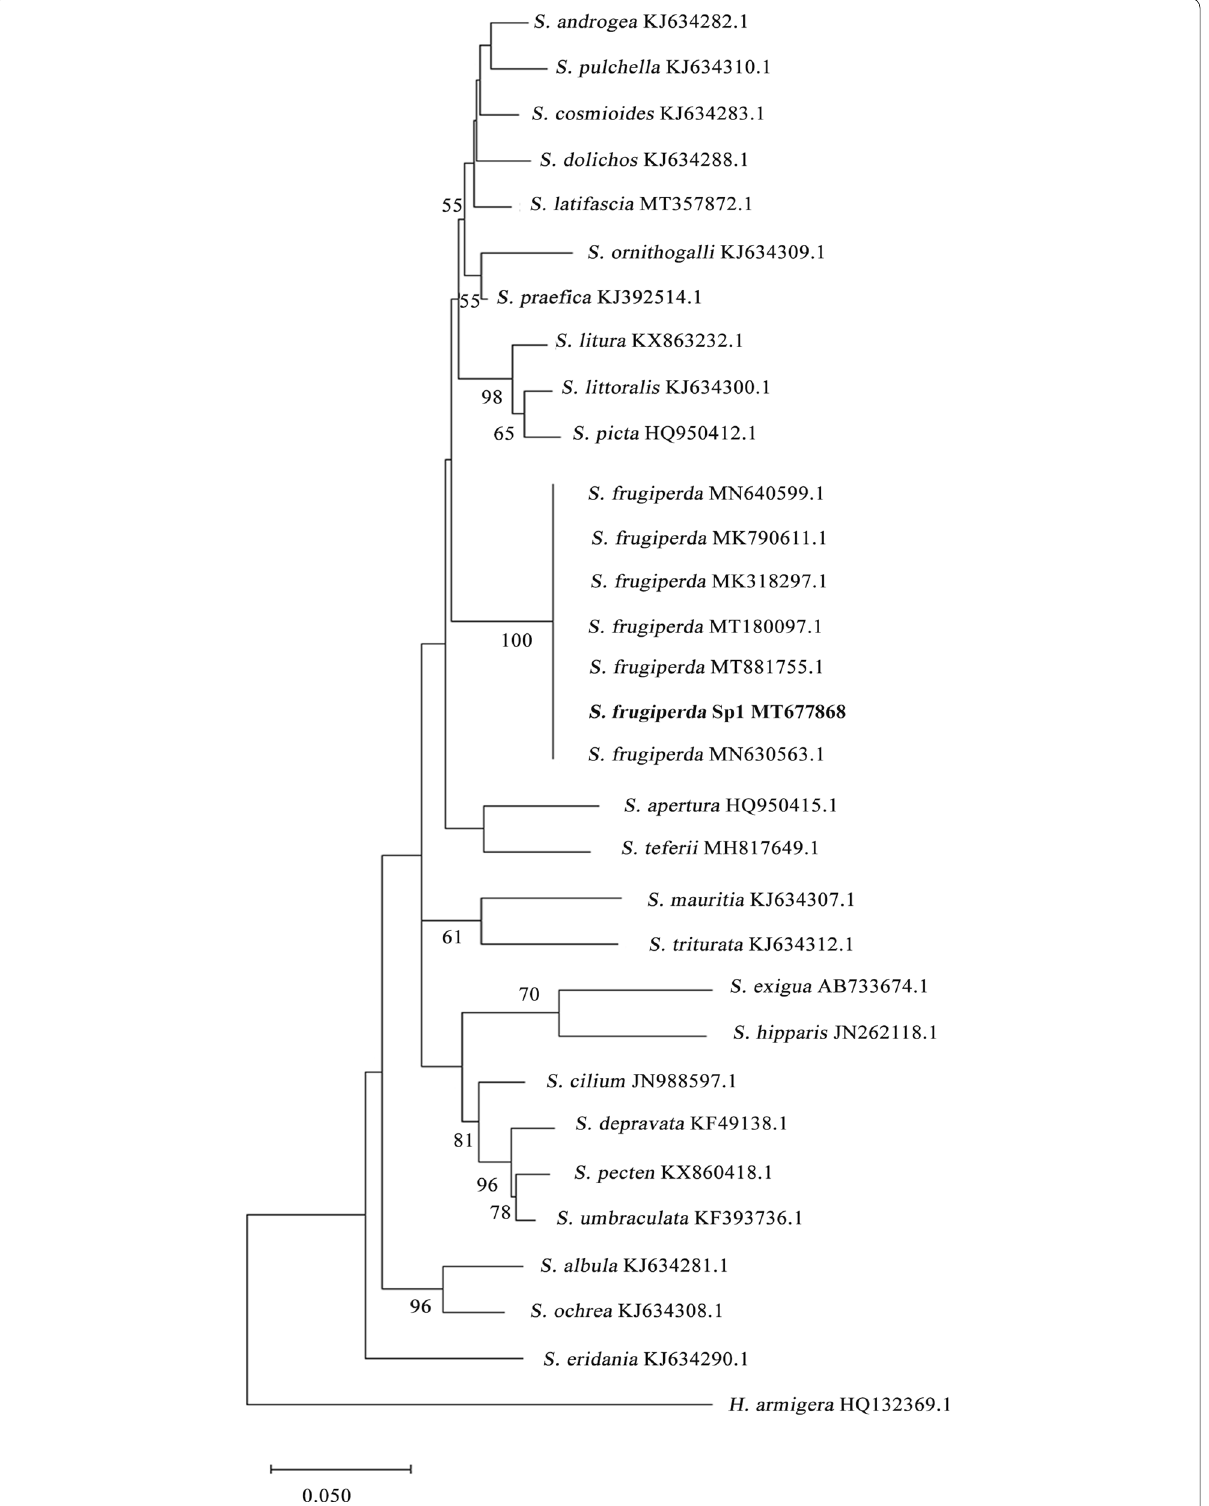
Fig. 1 Phylogenetic relationship of Spodoptera frugiperda with other Spodoptera spp. based on distance analysis of COI DNA regions. Maximum likelihood tree was constructed by using General Time Reversal model. Numbers at the nodes indicate bootstrap values (> 50%, 1000 replicates). GenBank Accession numbers are given after each